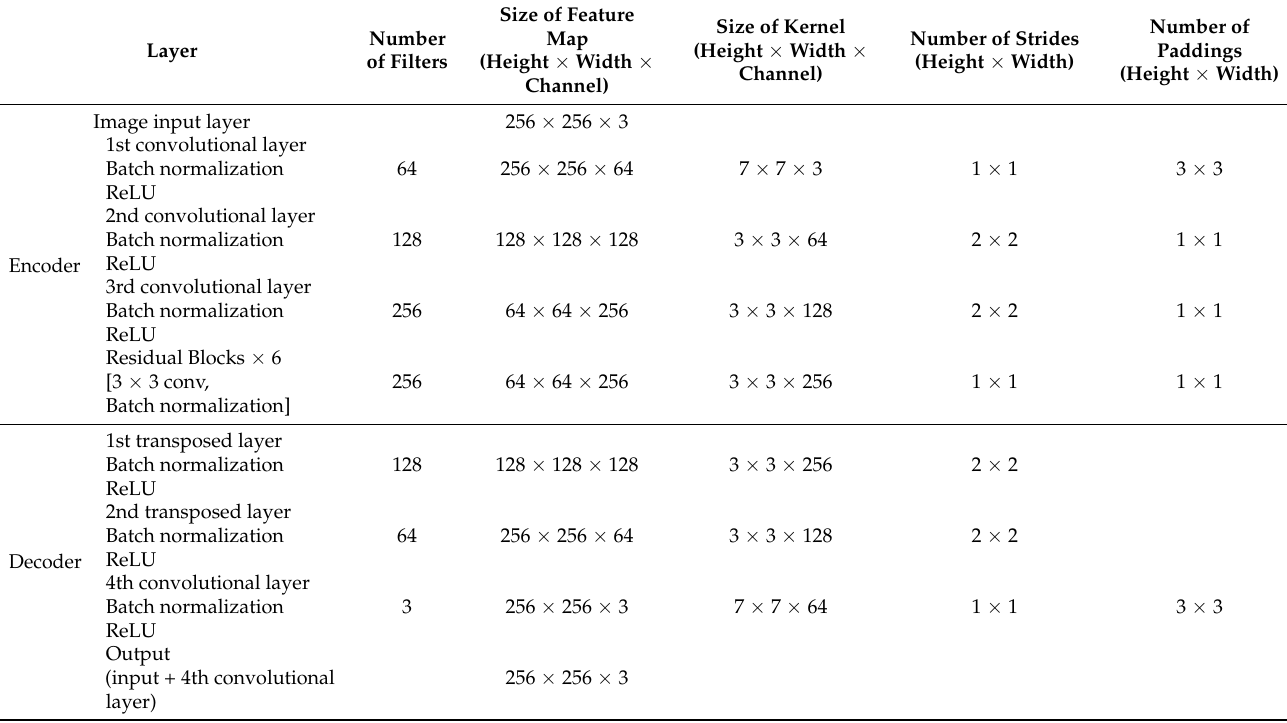
Figure 5. Discriminator of the modified DeblurGAN. Table 2. Descriptions of generator in modified DeblurGAN.